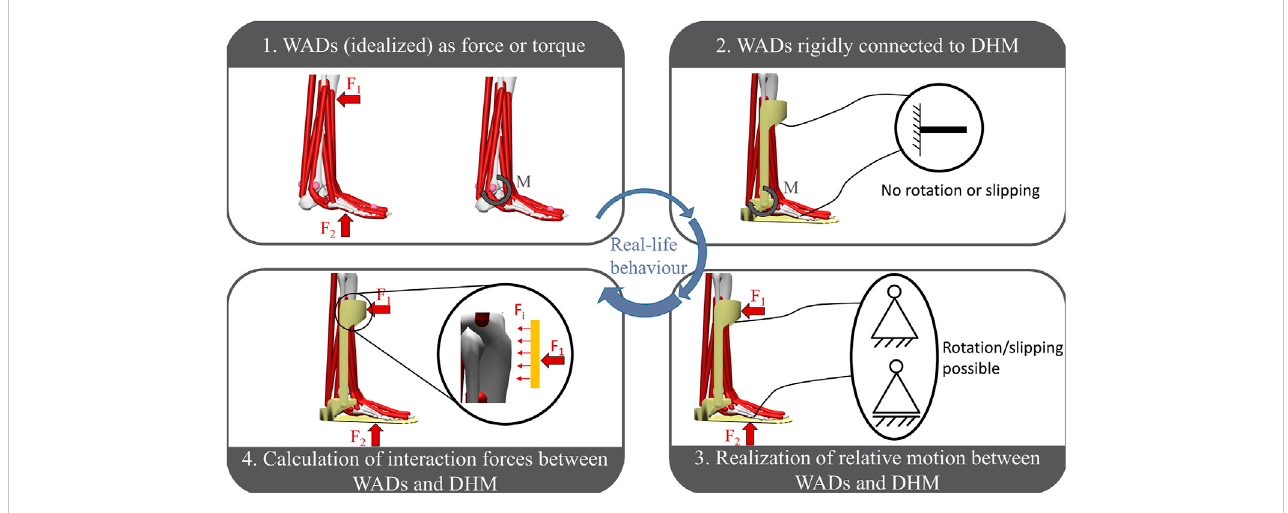
FIGURE 3 Identi fi edapproachesformodellingtheinteractionbetweenWADsandDHMsarrangedaccordingtotheirreproducibilityoftherealinterfacebehaviour, represented on the example of an ankle-foot-orthosis (AFO). To symbolise the possible motions at the interface of WAD and AFO fi gures of mechanical support structures are